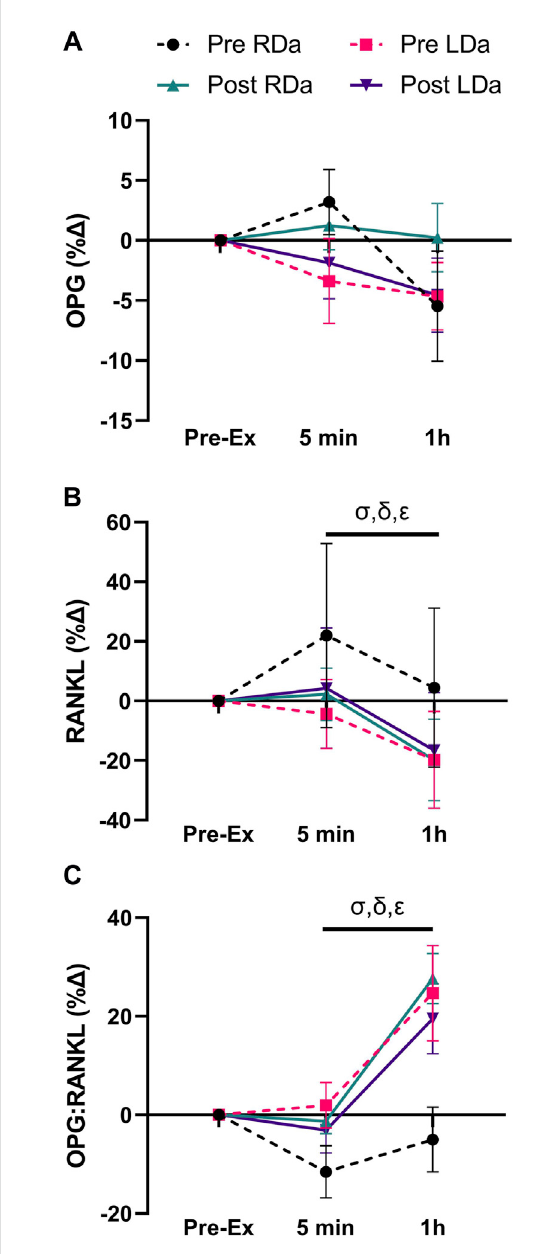
FIGURE 2 Serum osteoprotegerin (OPG), receptor activator nuclear factor kappa B ligand (RANKL), and OPG:RANKL ratio percent change to acute exercise at pre- and post-intervention in both RDa and LDa groups: percent change of serum OPG (A) , RANKL (B) , and OPG:RANKL ratio (C) at 5 min and 1 h post- exercise relative to pre-exercise in both RDa ( n = 14, 13 and 13, respectively) and LDa ( n = 15 for all markers) groups. σ = main effect for time ( p < 0.05) independent of intervention or group. Following the intervention*group interaction, δ = pairwise comparison between RDa and LDa at pre-intervention ( p < 0.05), ε = pairwise comparison between pre- and post-intervention in RDa only ( p < 0.05). Data are reported as mean ± SD.